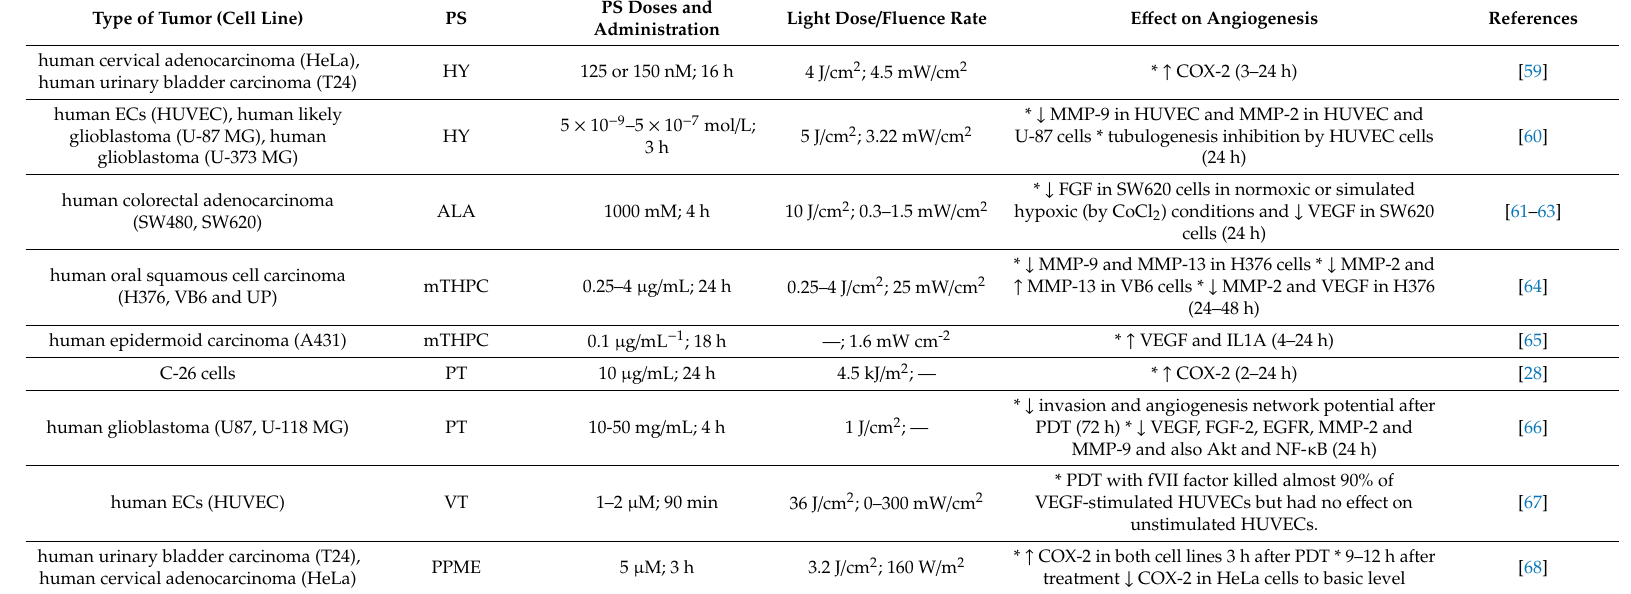
Table 3. In vitro experimental models utilized for PDT in relation to